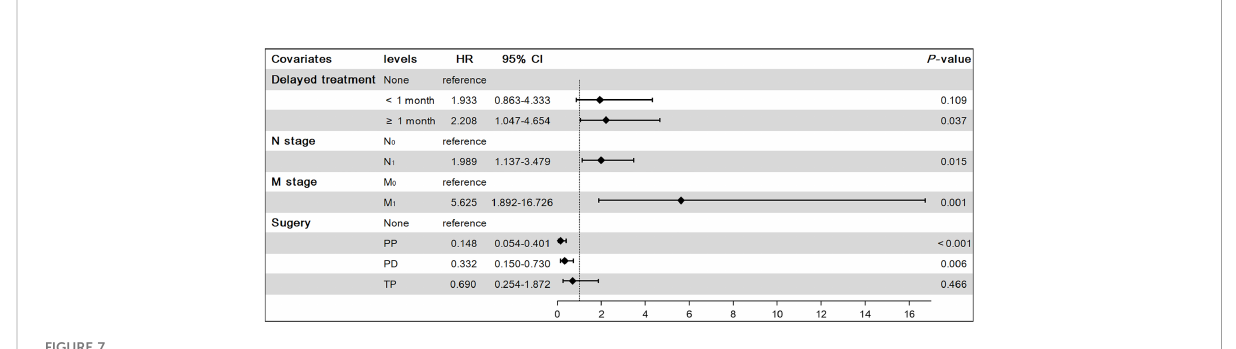
FIGURE 7 Results of multivariate competing-risk model on cancer-speci fi c survival (CSS). PP, Partial pancreatectomy; PD, Pancreatectomy and duodenectomy; TP, Total